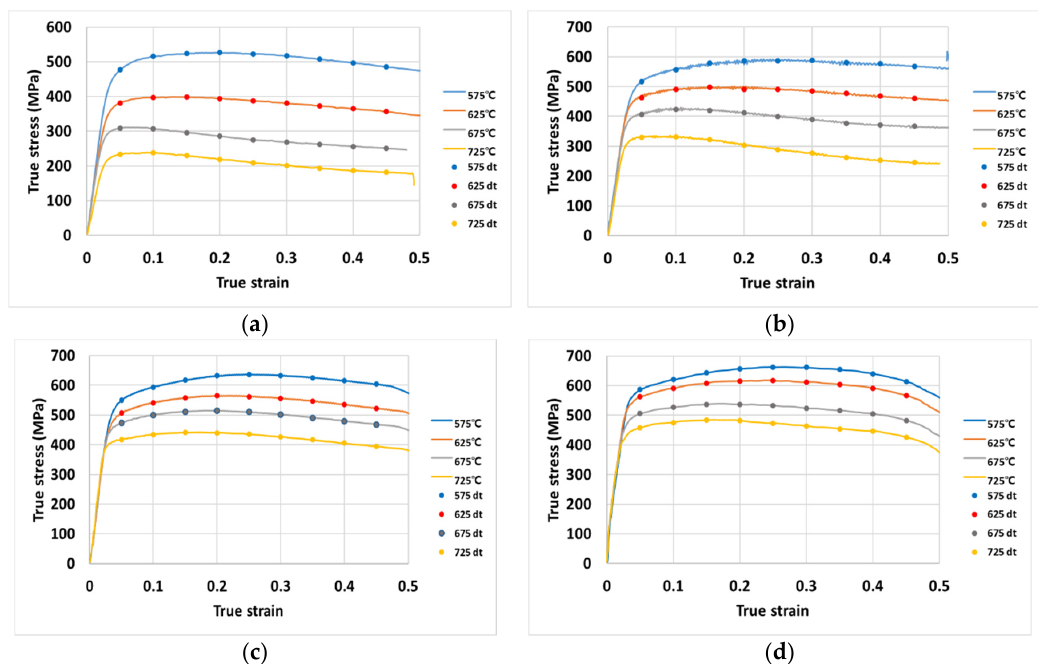
Figure 9. Predicted stress by decision tree modeling at: ( a ) 0.002 s − 1 ; ( b ) 0.02 s − 1 ; ( c ) 2 s − 1 ; ( d ) 20 s − 1 . Figure 10 is the part of the decision tree structure for the current model.